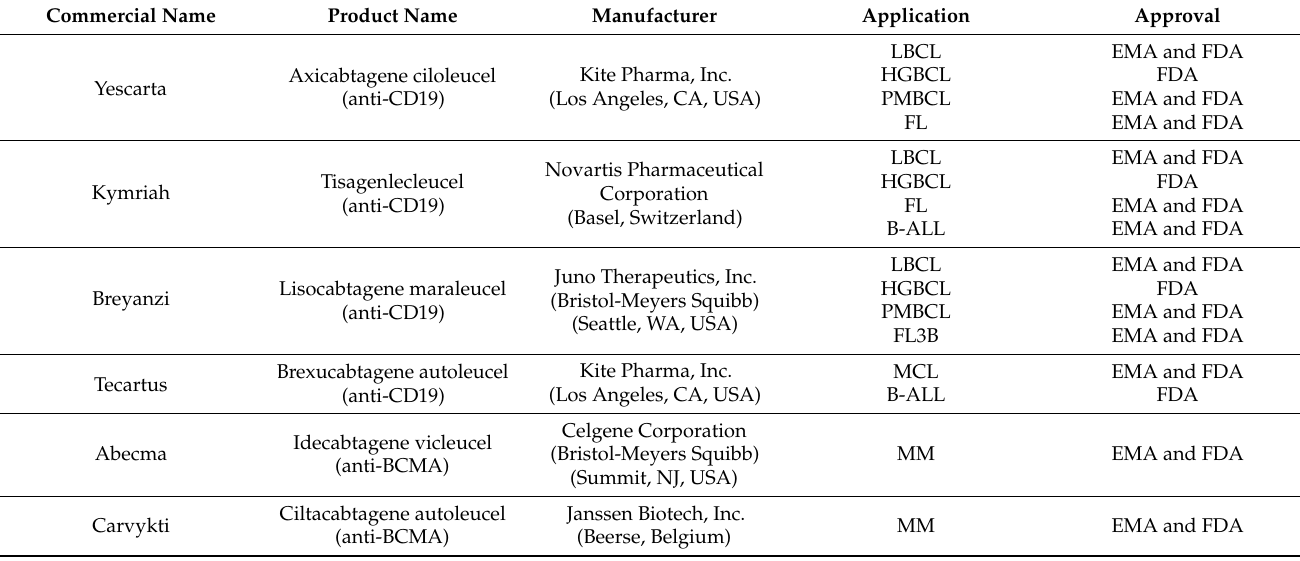
Table 1. List of the available CAR T cell products, available in either Europe, under the EMA, or the USA, under the FDA (abbreviations in